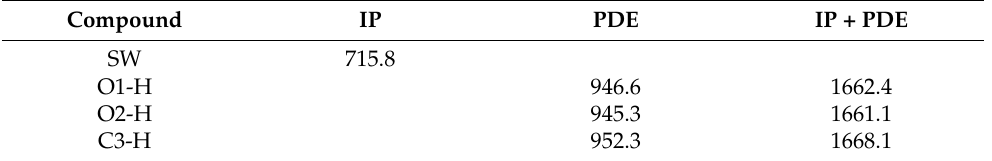
Table 4. Calculated ionization potential (IP) and lowest proton dissociation enthalpy (PDE) values in kJ/mol for Santowhite (SW) determined at the M06-2X/6-311++G(2d,2p) level of theory in gas phase. Compound IP PDE